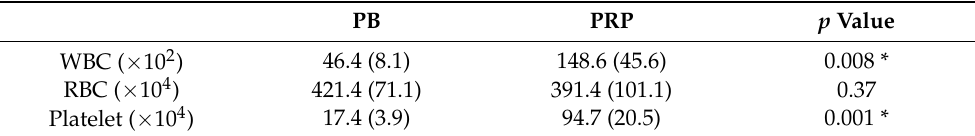
Table 2. Blood cell counts in peripheral blood and platelet-rich plasma.